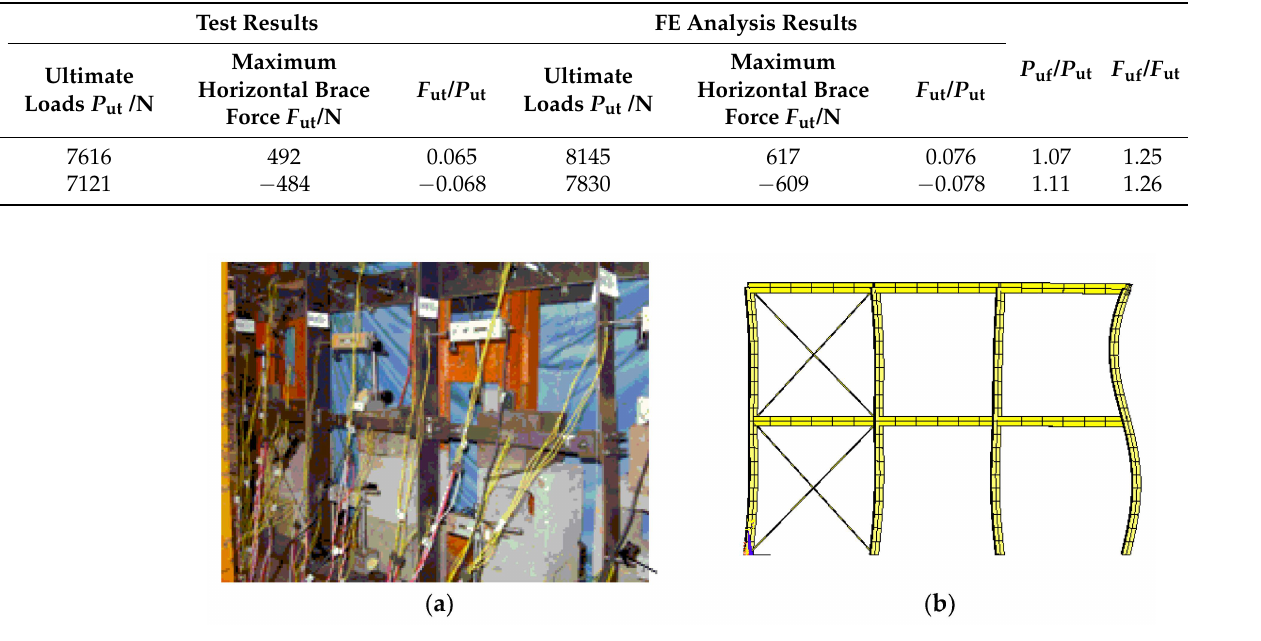
Figure 1. Instability deformation obtained from the tests and FE analyses of Group 1. ( a ) Tests; ( b ) FE